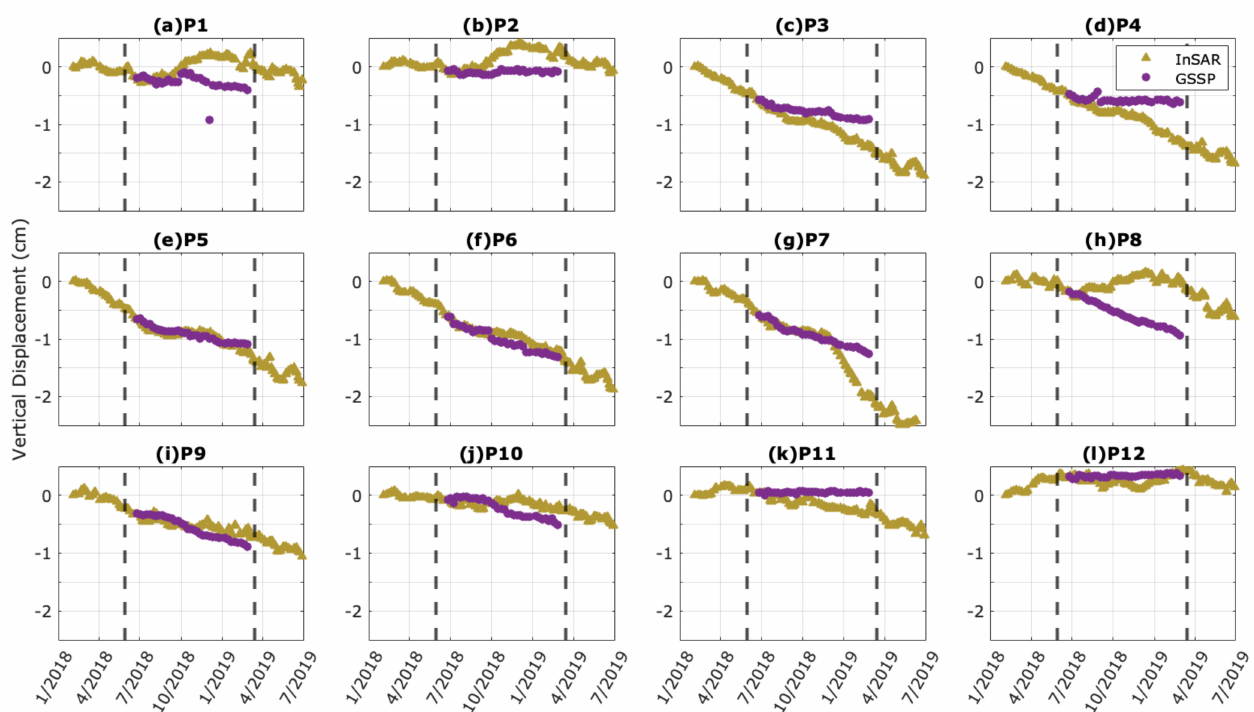
Figure 9. (a – l) Comparison of vertical InSAR deformation and ground-based data from points indicated in Figure 8b. InSAR measurements span 3 February 2018 to 28 June 2019. Ground-based data acquired between 25 June 2018 and 25 February 2019. Vertical dashed lines represent the initiation and completion of the crossover cavern sequential excavation on 30 May 2018 and 14 March